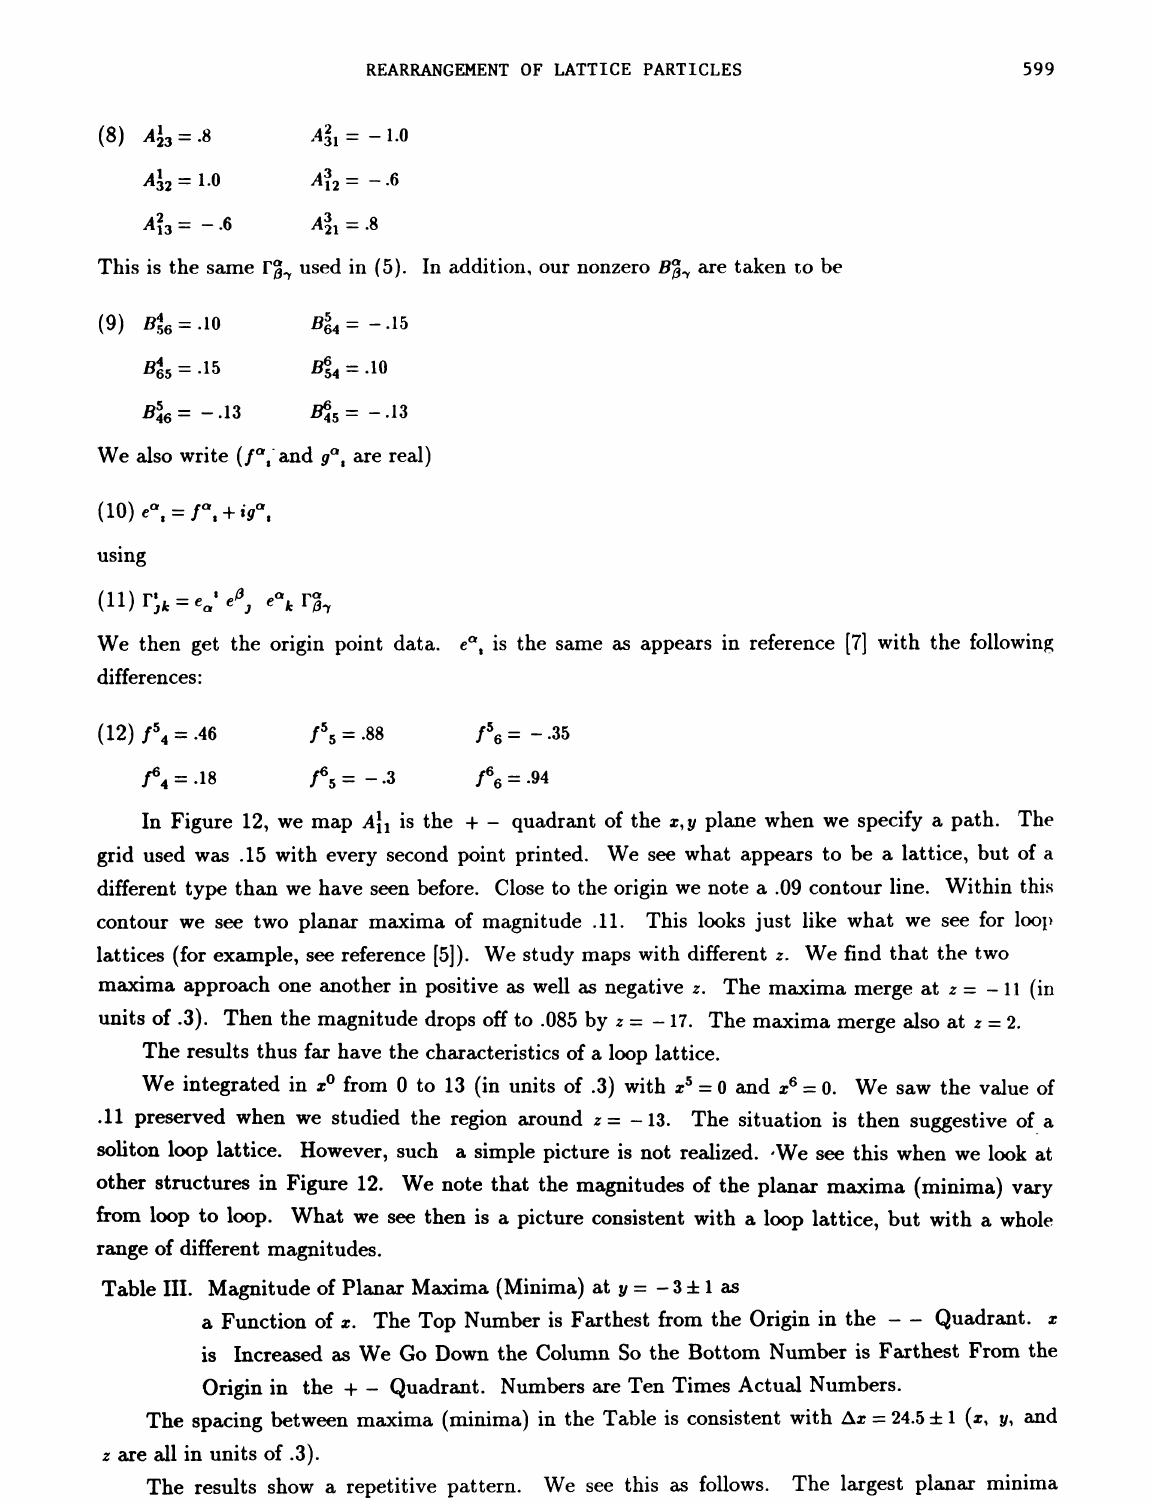
Table III indicates an oscillatory pattern for the magnitude of the planar maxima (minima). The magnitudes also vary in an oscillatory way as we alter y for fixed